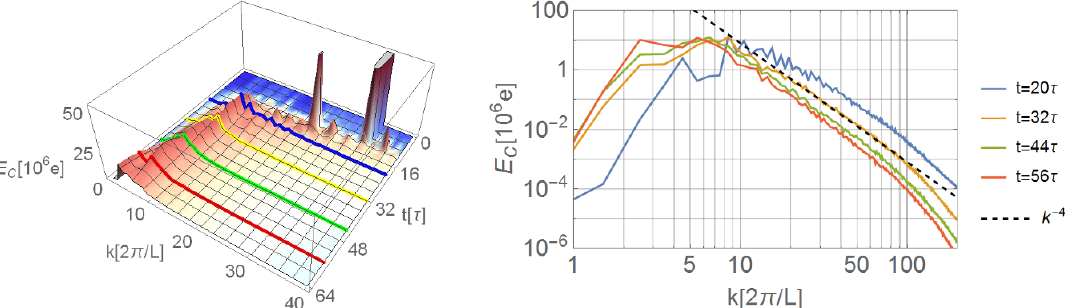
Figure 6 . The energy spectrum for two dimensional (cid:13)ow with an initial Reynolds number of Re = 1562 : 5 initial Mach number given by M = 0 : 5 and initial mode n = 32. The right plot provides an overlay of the energy spectrum at various times. An emergent power law E C ( t; k ) (cid:24) k (cid:0) 4 is observed from k (cid:24) 10 (cid:2) 2 (cid:25)=L to k (cid:24) 100 (cid:2) 2 (cid:25)=L . By restricting oneself to lower wavenumber it is possible to (cid:12)t the data to other power law behavior though the merit in doing so is unclear.